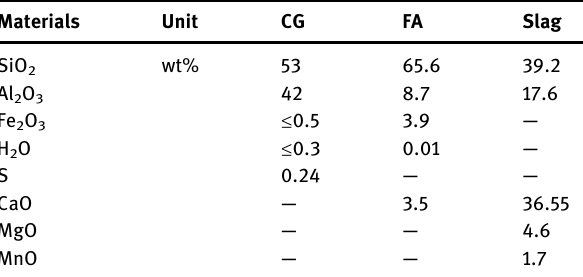
Table 1: Chemical composition of cementitious materials